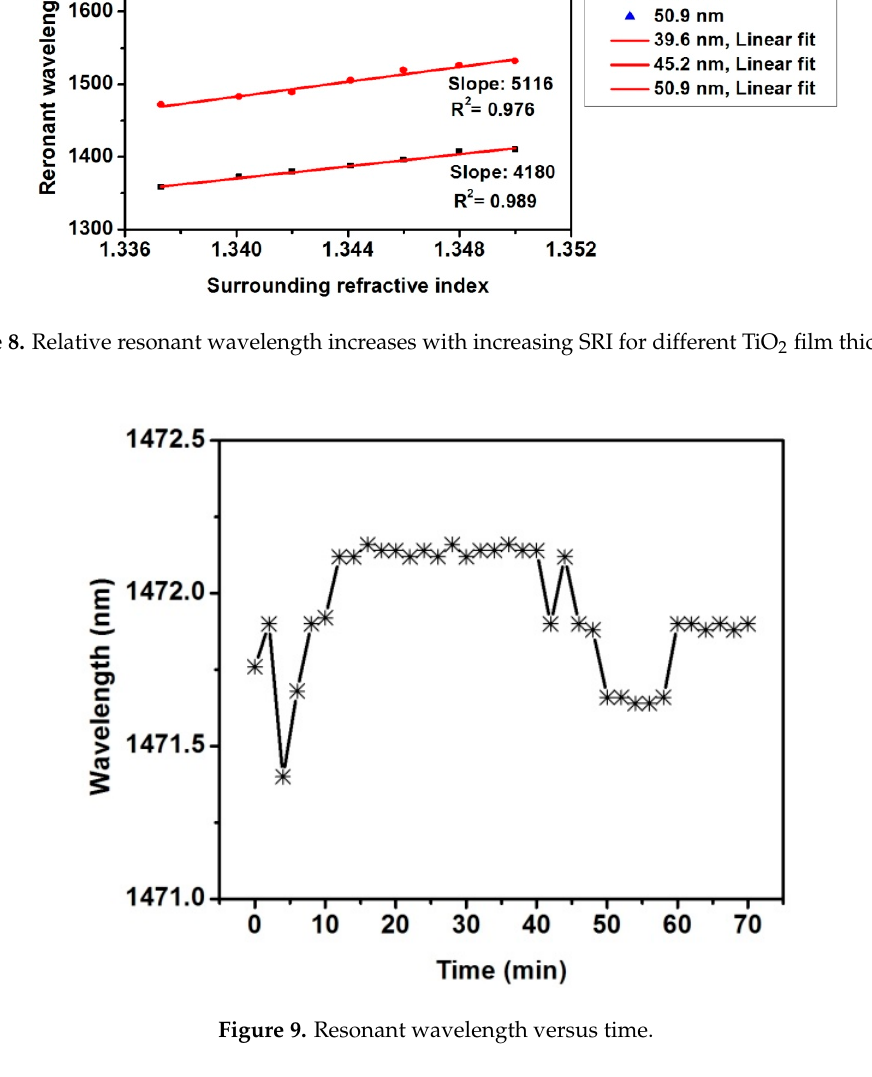
Sensors 2016 , 16 , 1295